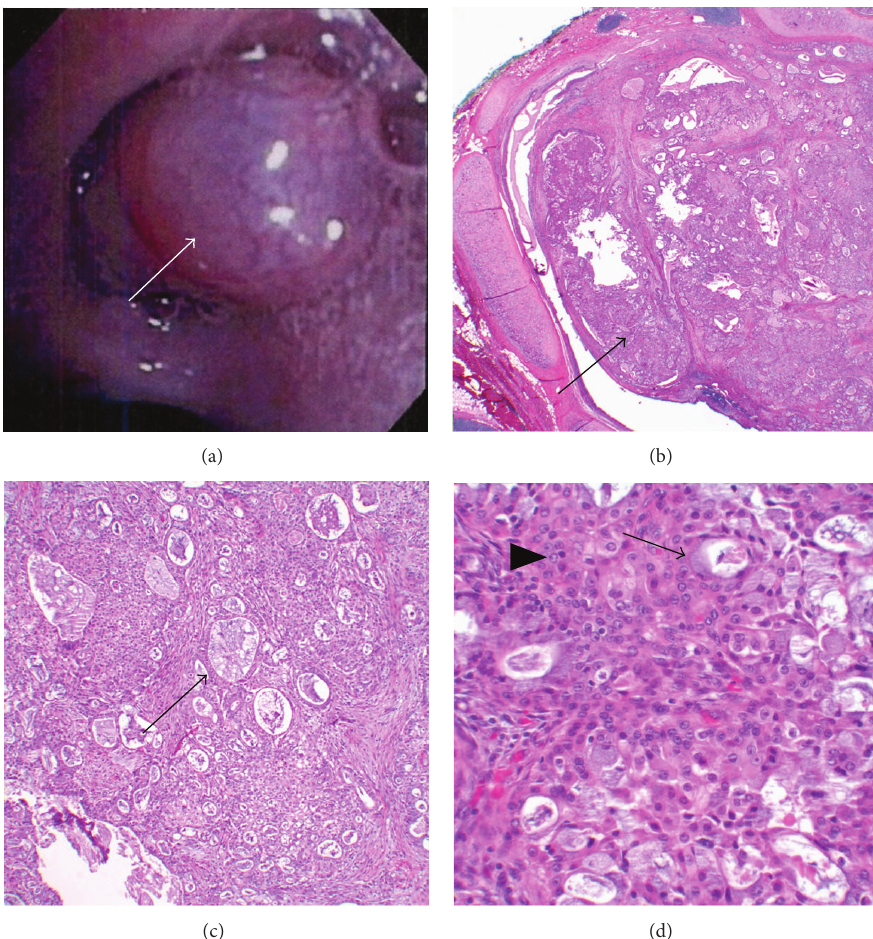
Figure 2: (a) Bronchoscopic image showing a smooth, well-circumscribed endobronchial tumor (arrow) at the orifice of the right upper lobe bronchus. (b) Low power (20x) microscopic image showing a polypoid endobronchial mass extending into the bronchial lumen (arrow) and superficially invading the submucosa. (c) Tumor is comprised of glands, tubules, and cysts containing mucin (arrow) separated by a fibrous stroma (100x). (d) Higher power (400x) microscopic image showing a mixture of mucin-secreting cells (arrow) admixed with sheets of squamoid and intermediate cells (arrowhead) intimately admixed with the glandular component. The cells lack significant mitotic activity, nuclear pleomorphism, and cellular necrosis characteristic of a low-grade mucoepidermoid